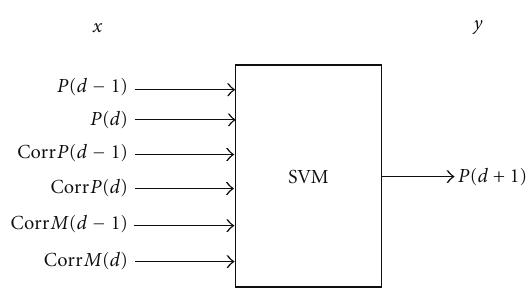
Figure 3: Data representation for pollutant predictive model.